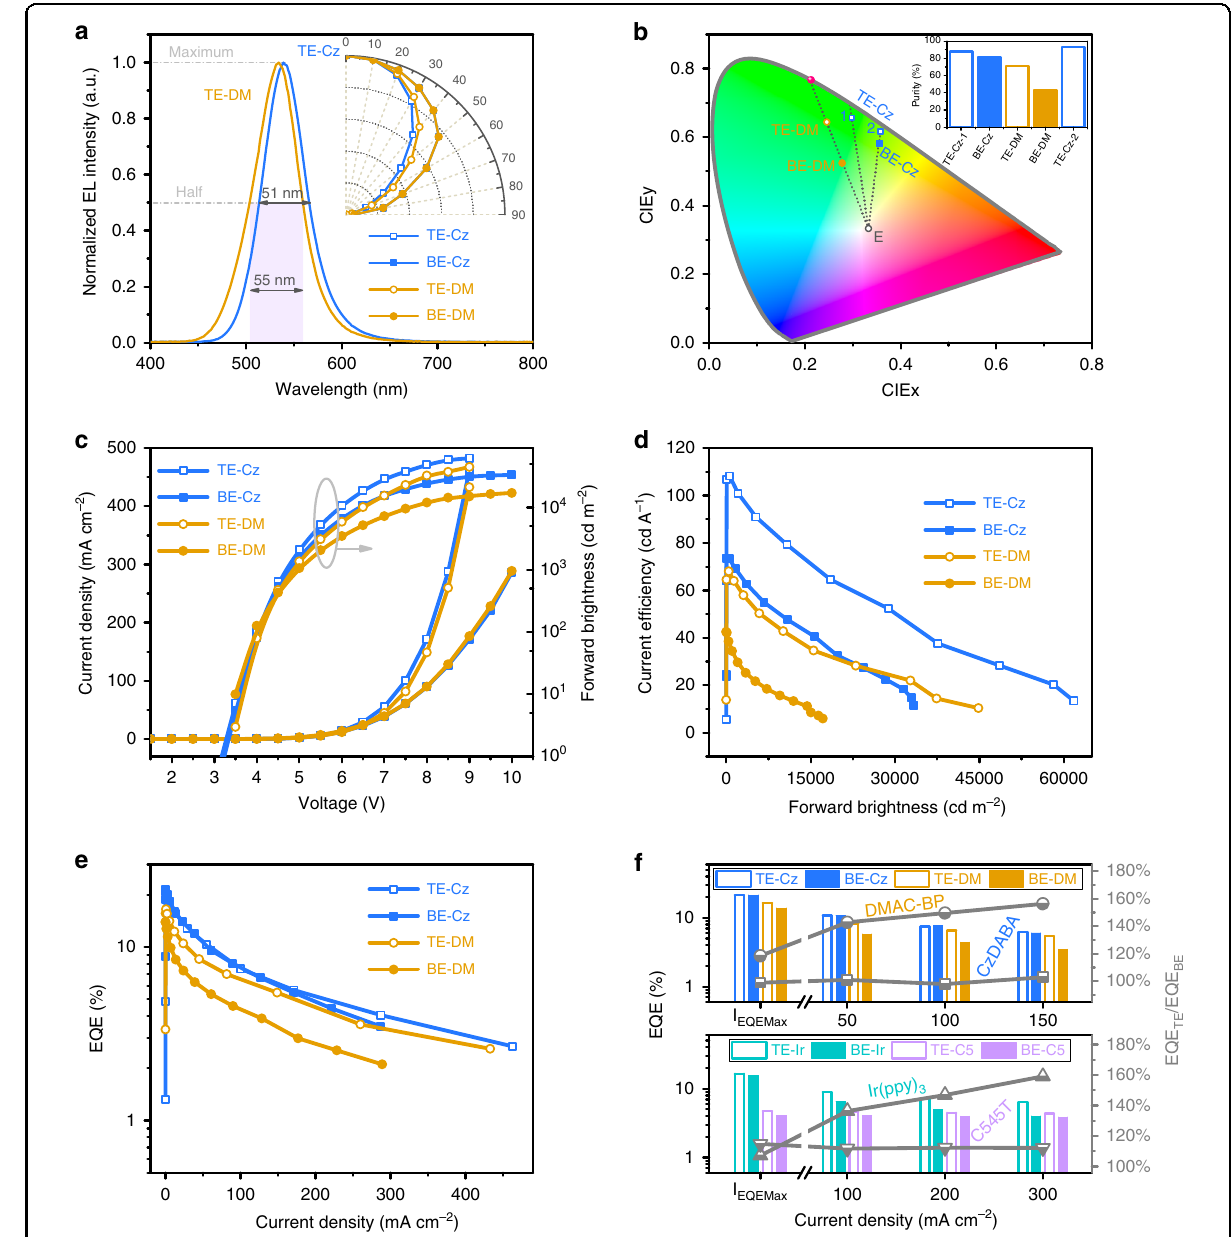
Fig. 2 Device performances of top-emitting and bottom-emitting TADF OLEDs. a EL spectra and EL emission intensity angle distribution, b CIE coordinates and excitation purity, c current density – voltage-forward brightness characteristics, d current ef fi ciency-forward brightness and e EQE- current density characteristics of devices BE-Cz, BE-DM, TE-Cz, and TE-DM. f The values of the EQE of the top-emitting and conventional devices with CzDBA, DMAC-BP, Ir(ppy) 3 , and C545T, and their EQE TE /EQE BE ratios at different current densities ( I EQEMax corresponds to the current density of the maximum